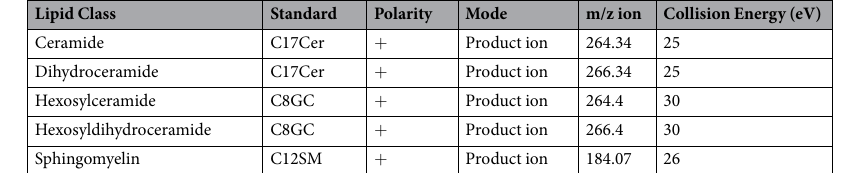
Table 4. Standards and conditions for mass spectrometric analysis of RBC